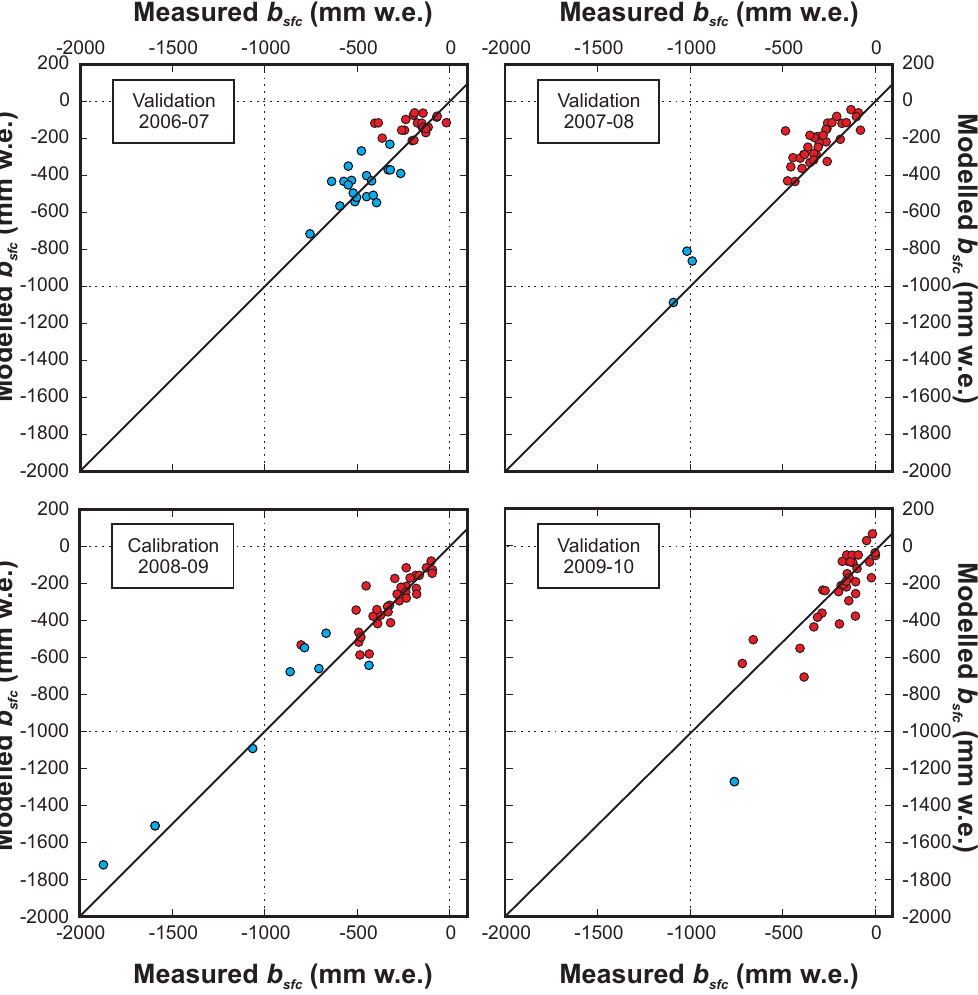
Fig. 5. Measured and modelled point b sfc of the individual ablation stakes for the calibration and validation runs (mmw.e.). Blue dots indicate that the model handled the surface of the position of the stake as ice at the end of the modelled period.